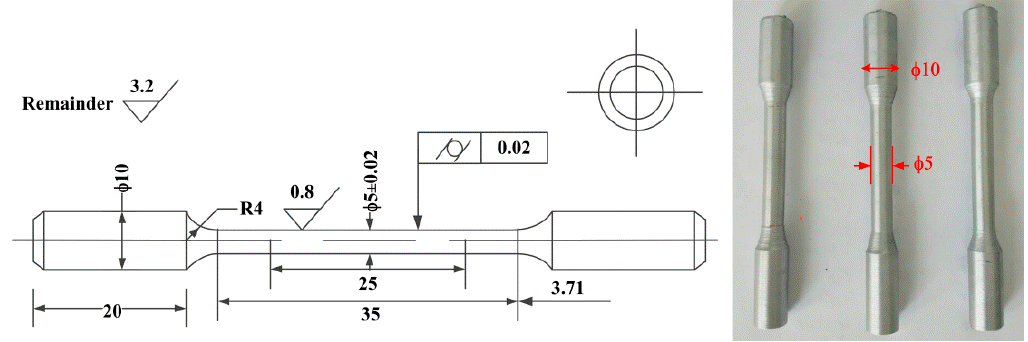
Figure 1. The dimensions of tensile specimen. (unit: mm).